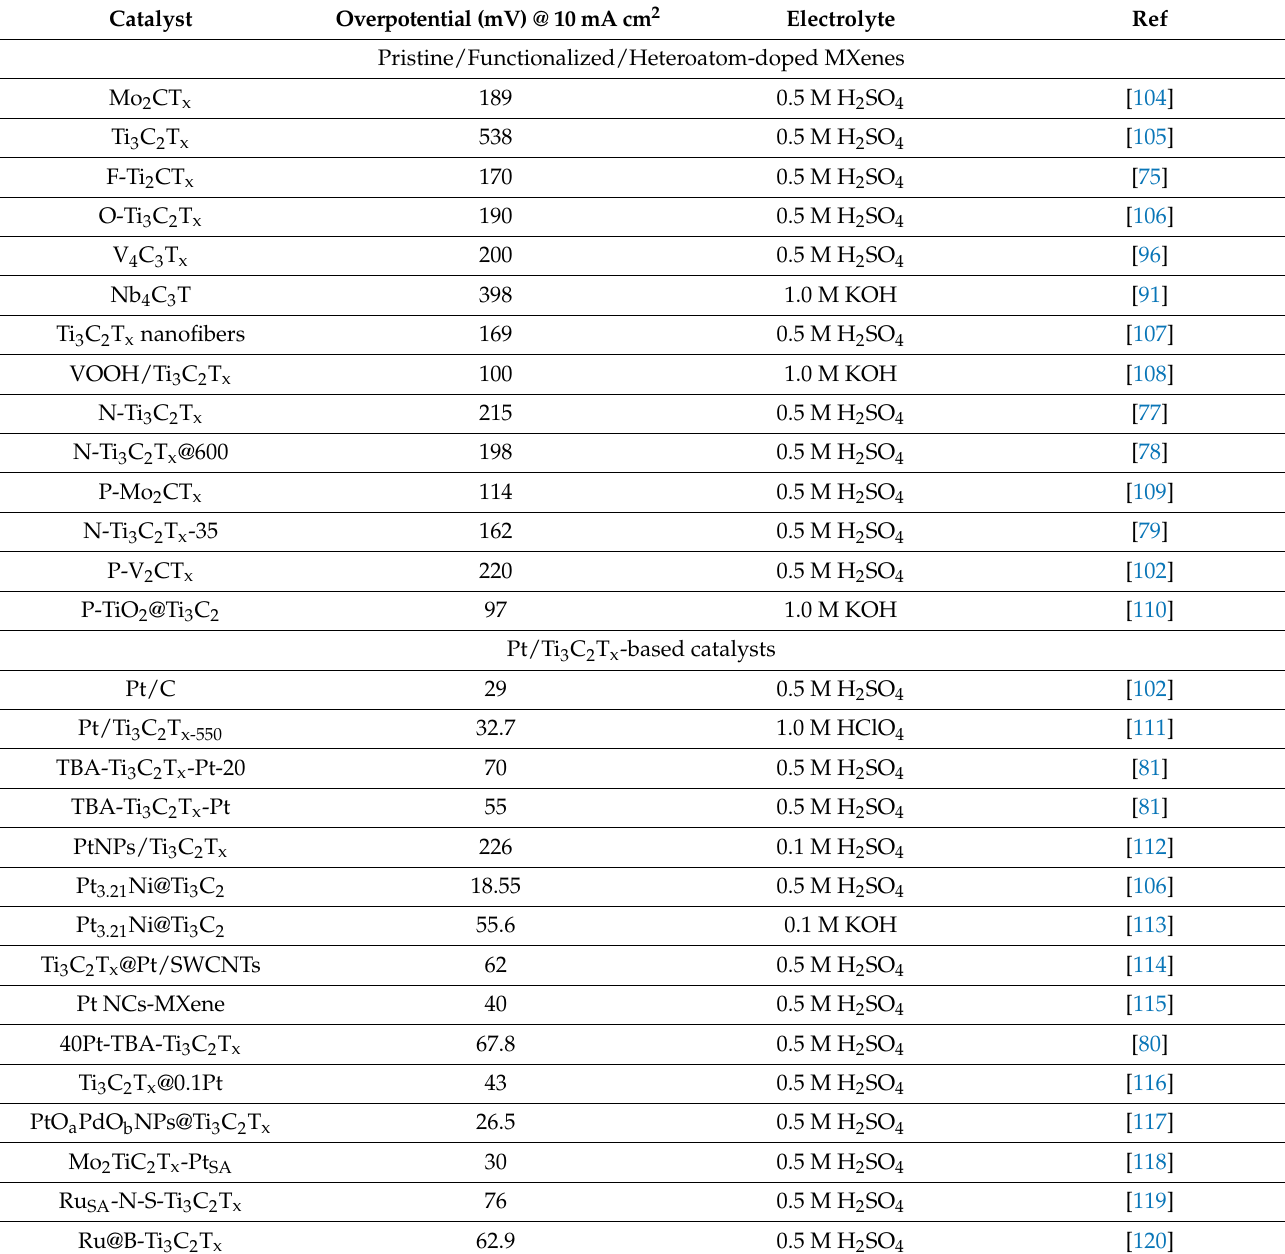
Table 2. Summary of electrochemical performance of MXene-supported catalysts for